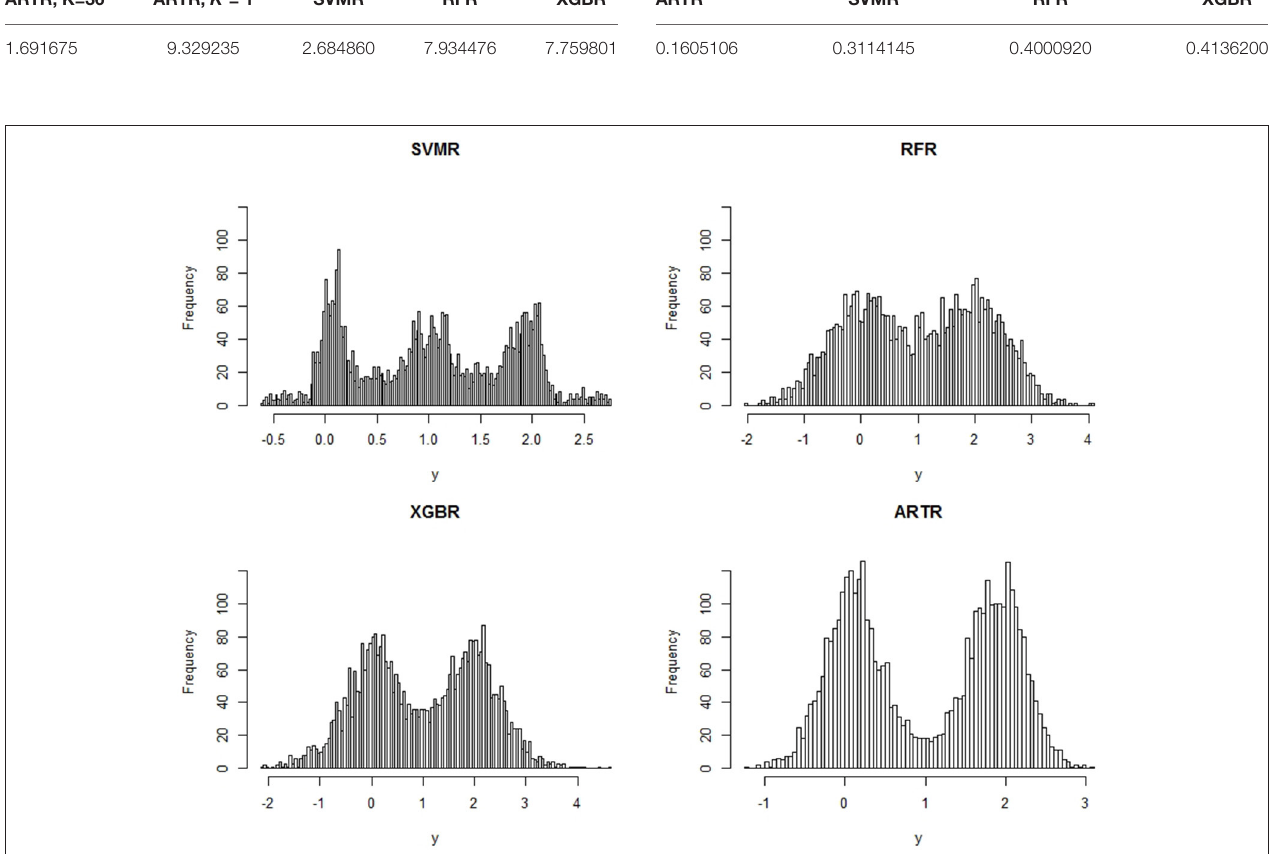
FIGURE 1 | Histograms of fitted data from different